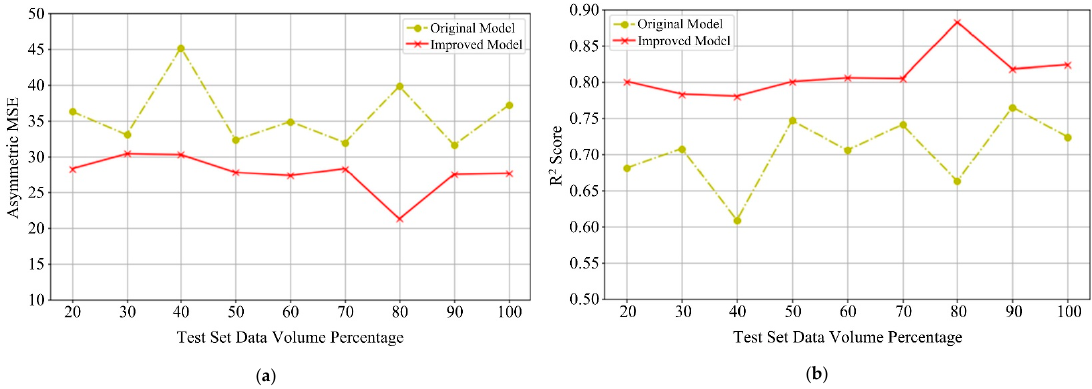
Figure 10. Comparison results of different evaluations under different sample. ( a ) Asymmetric Loss. ( b ) R 2